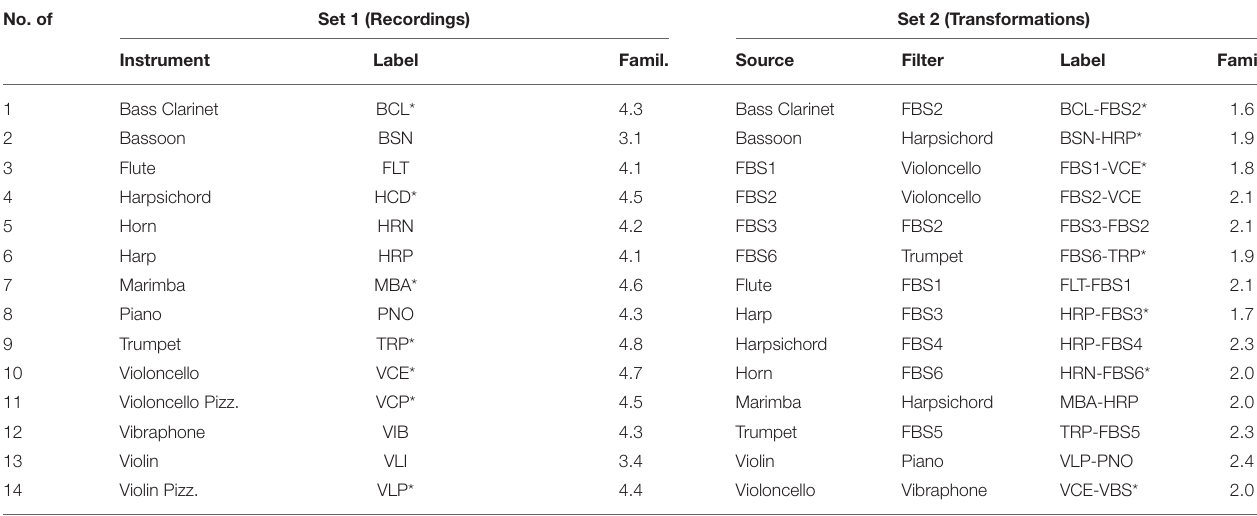
TABLE 1 | List of recordings and transformations used in Experiments 2A and 2B with mean familiarity ratings. No. of Set 1